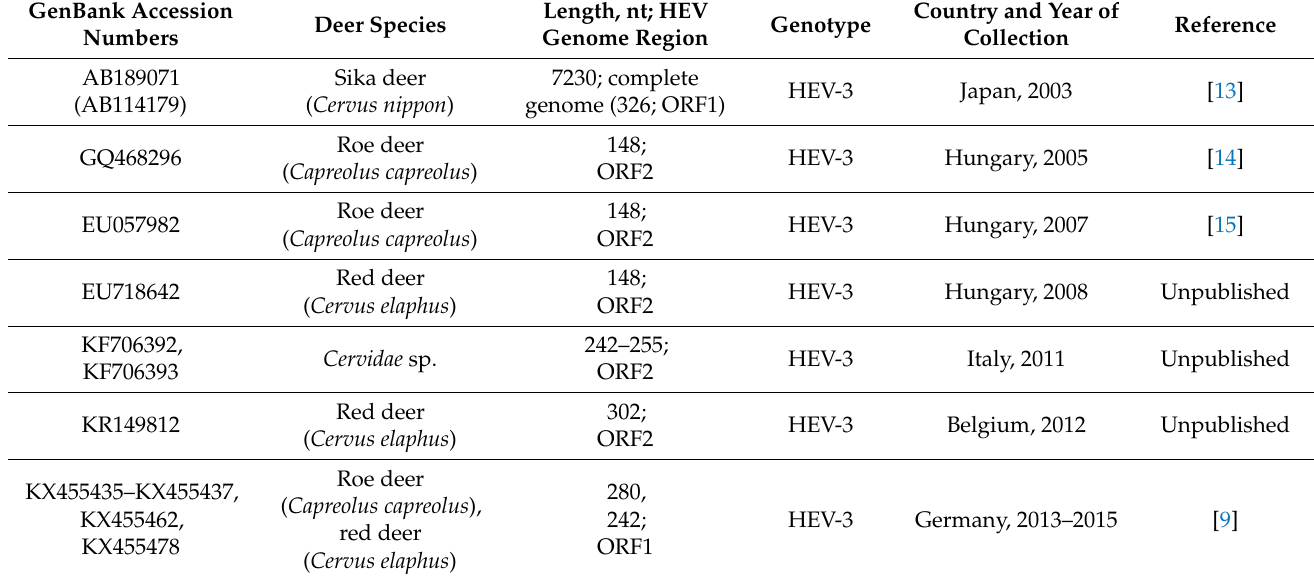
Table 1. Information on deer HEV sequences that were used in the